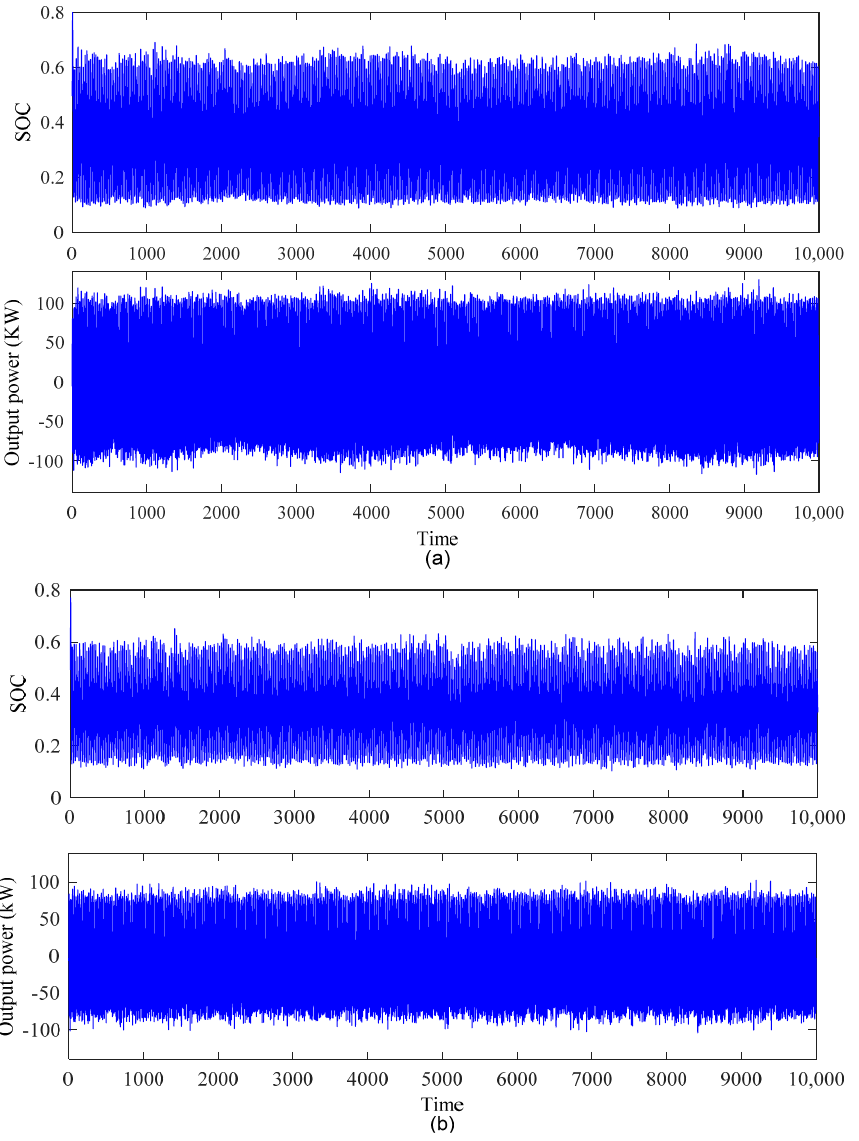
Figure 5. Comparison of state-of-charges (SOCs) and power outputs of energy storage unit. ( a ) The proposed method; and ( b ) Robust MPC via scenarios optimization.